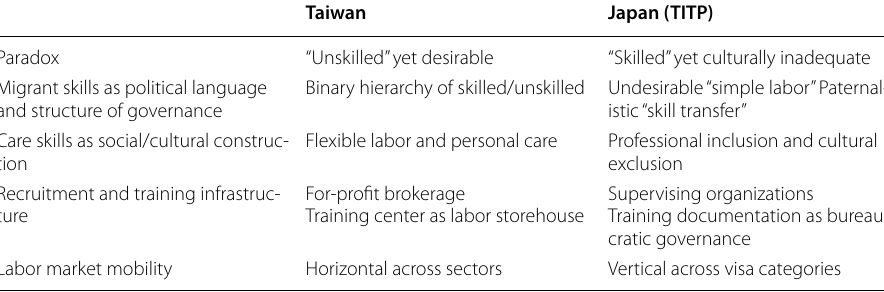
Table 1 Migrant care skill regimes: comparing Taiwan and Japan